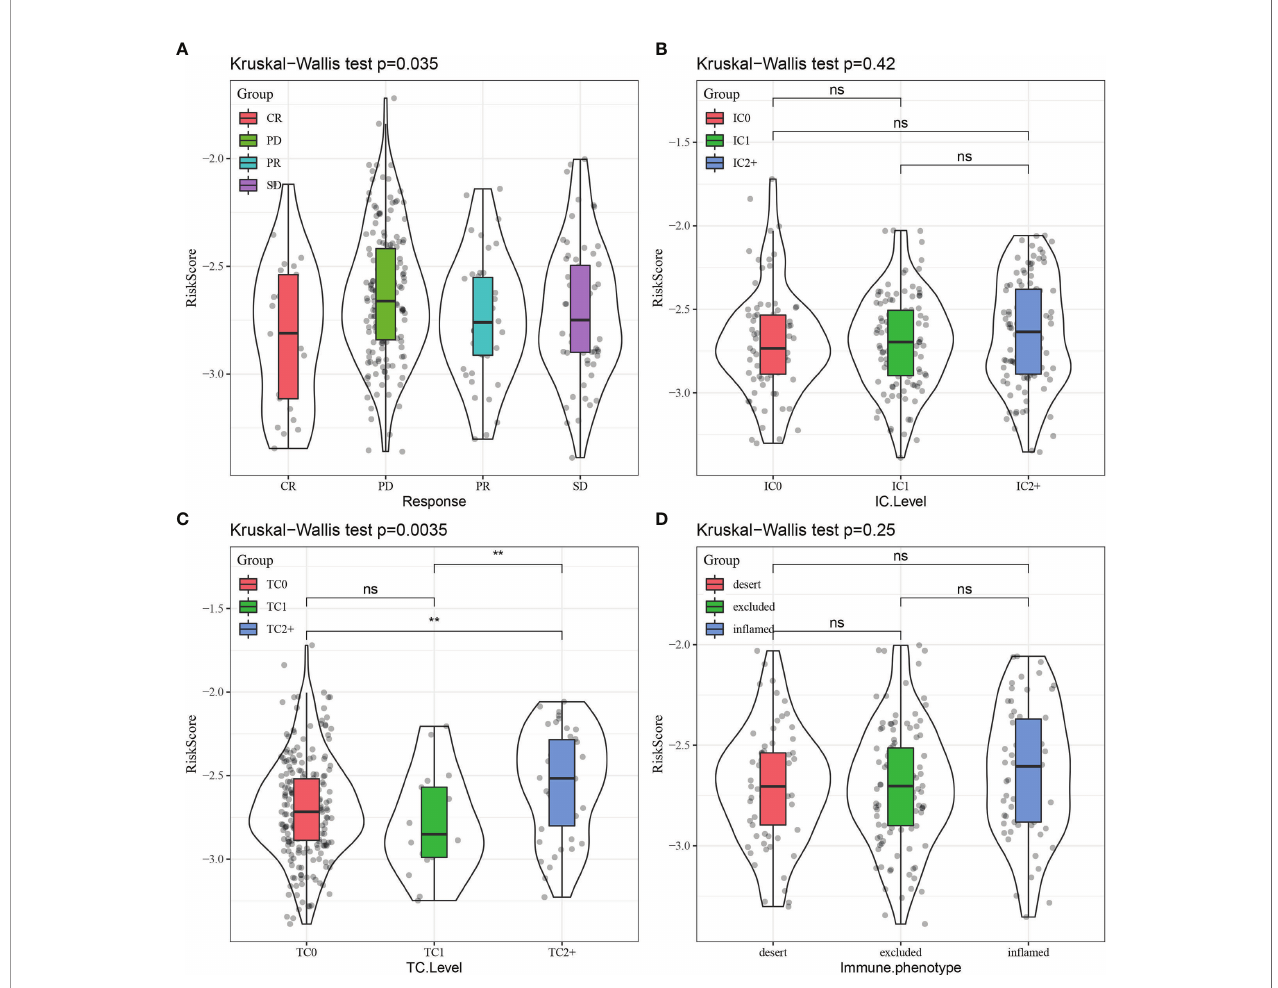
FIGURE 15 | Comparison of RiskScore distribution across different subgroups for (A) immunotherapy response, (B) immune cell (IC) level, (C) tumor cell (TC) level, and (D) immune phenotype. CR, complete response; PR, partial response; SD, stable disease; PD, progressive disease. **p < 0.01; ns, no signi fi